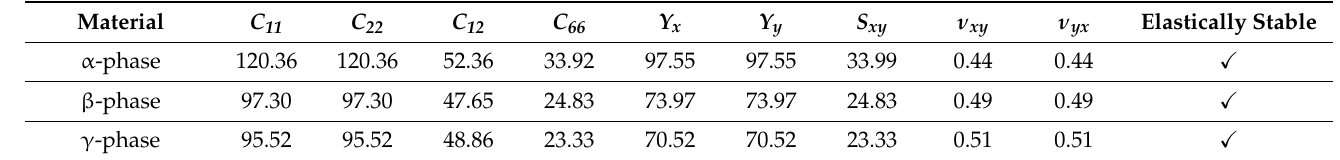
Table 3. The values of elastic constants ( C ij in (N/m)), shear moduli ( S ), and Young’s moduli ( Y ) in N/m and Poisson’s ratios ( ν ) for three Heuslerene phases of Co 2